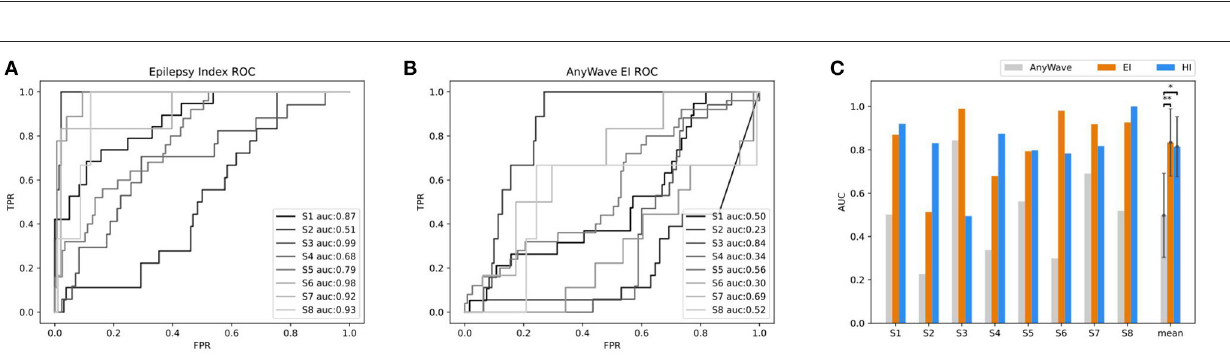
FIGURE 8 | Validations of the SOZ prediction results of BrainQuake comparing with clinically annotated SOZs. (A) The receiver operator curve (ROC) and area under the curve (AUC) results of SOZ prediction, based on EI. Case S2 shows a low AUC of 0.51 (low predictive effect), while HI-guided prediction of S2 is 0.83, which is highly consistent with the clinically annotated SOZs. That is because the ictal data of S2 displays similar seizure onset activities within each channel, and the EI method cannot tell the difference from either their timing orders or their energy strengths. The case of S2 suggests that when the ictal data cannot provide sufficient diagnostic information, the interictal data can be used to provide extra information for SOZ location, showing the essential value of interictal SEEG data analysis. (B) The ROC and AUC results of SOZ prediction, based on HI. Case S3 shows a low AUC of 0.49 based on HI but a high AUC of 0.99 based on EI. The HI results of S3 performed poorly because those false positive channels recorded plentiful high-frequency noises. EI and HI methods provide prediction results from different perspectives of views, so we recommended surgeons take a comprehensive consideration on both of them. (C) The HI results of S2 (marked with larger scales of contacts) and cortical reconstruction are displayed at the same time with clinically annotated SOZs (marked with red color).